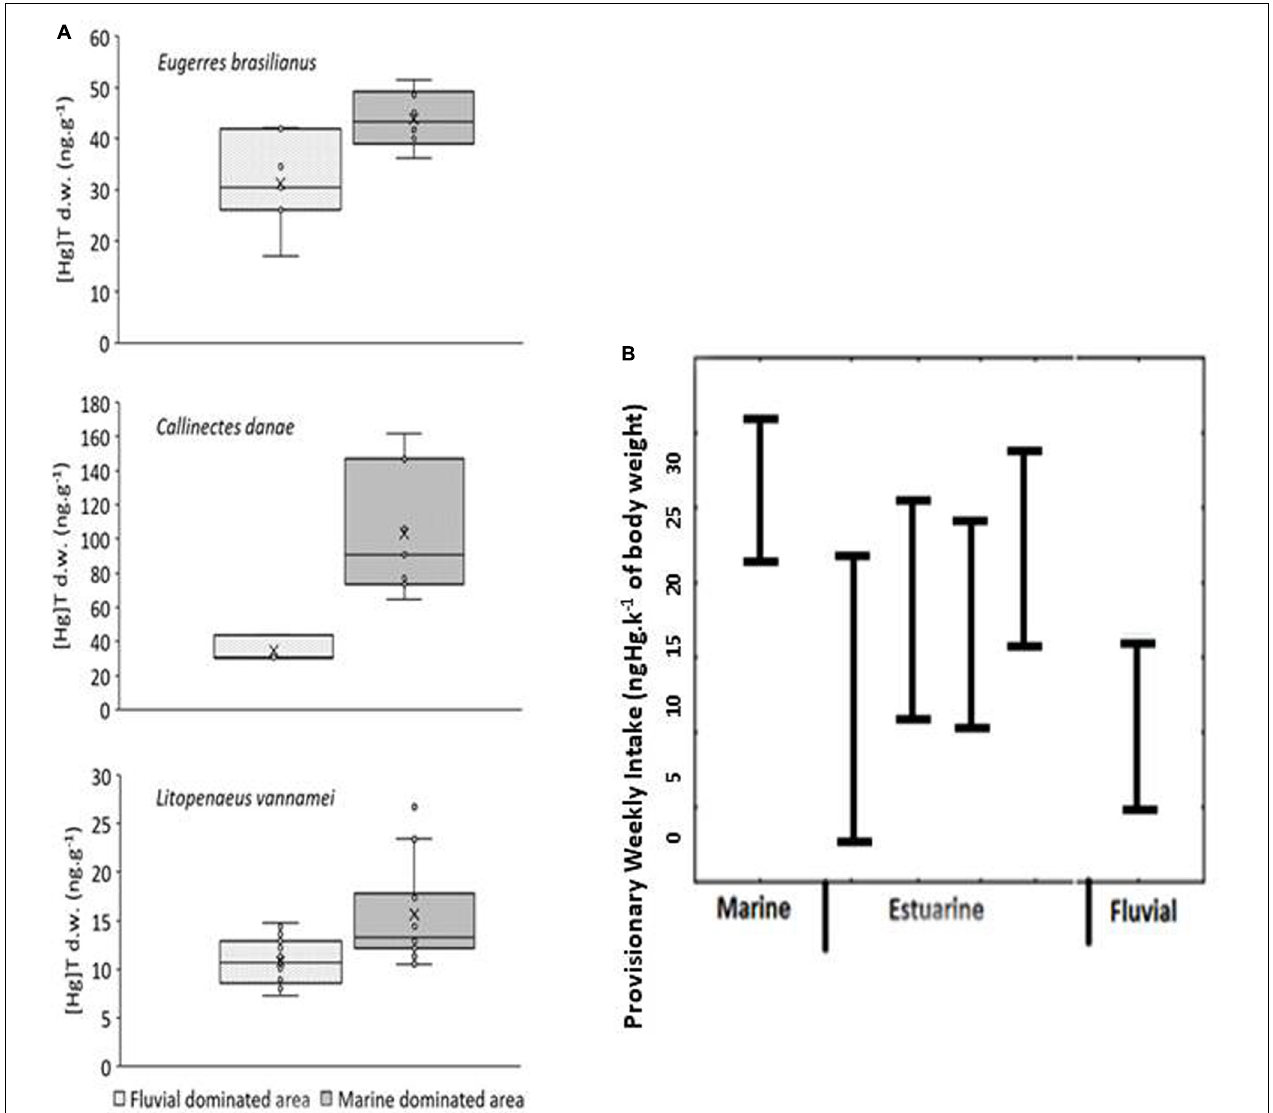
FIGURE 4 | (A) Mercury distribution in aquatic organisms along the Jaguaribe River estuary, after Moura and Lacerda (2018). (B) Provisionary Hg Weekly Intake (ngHg.k - 1 of body weight) estimated for human communities resident along the Jaguaribe River estuary, after Costa and Lacerda